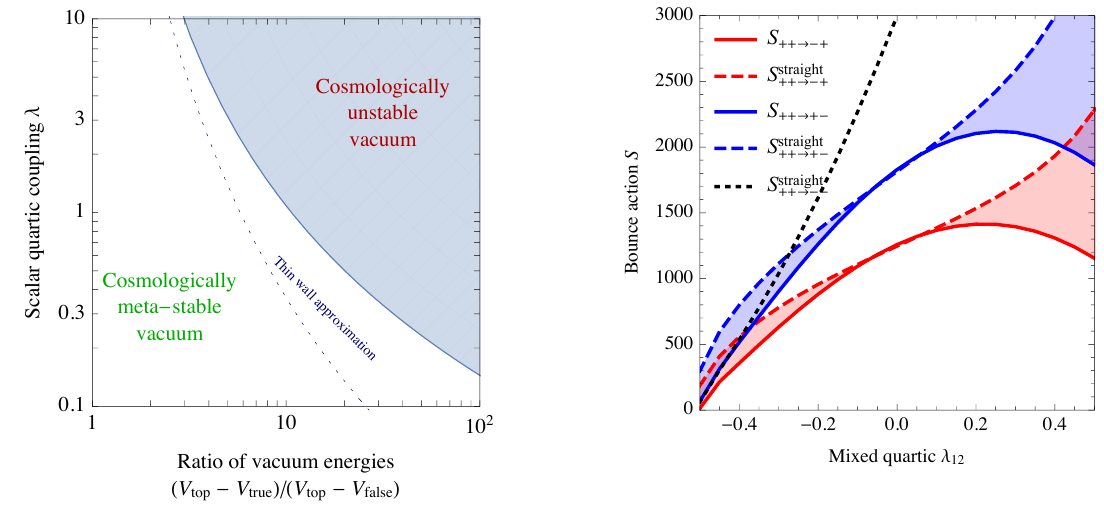
Figure 3 . Left: we consider a potential V = (cid:0) M 2 (cid:30) 2 = 2 (cid:0) A(cid:30) 3 = 3 + (cid:21)(cid:30) 4 = 4 and show the largest (cid:21) allowed by vacuum stability as function of the ratio R = ( V top (cid:0) V true ) = ( V top (cid:0) V false ) of the vacuum energies at the false and true vacua. We see that even large non-perturbative (cid:21) are allowed for order one ratios R (cid:24) 2. Right: bounce actions for a 2-(cid:12)eld potential with (cid:21) 11 = (cid:21) 22 = 1, v = v 1 = v 2 , V odd = 0 : 2 (cid:30) 1 v 3 + 0 : 18 (cid:30) 2 v 3 1 2